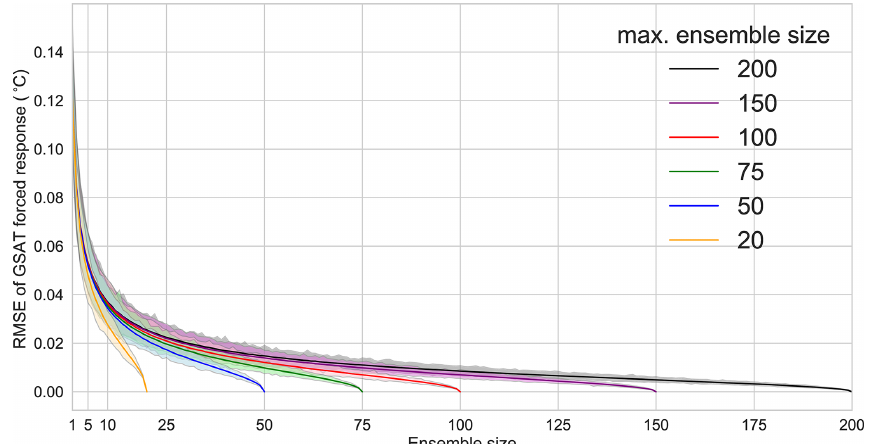
Figure A2. In a smaller ensemble, the RMSE converges to zero earlier. This is caused by resampling and does not indicate that the error is small. The black line shows the mean RMSE for GSAT for ensemble sizes from 2 to 200. The reference is the 200-member mean from Fig. 1, and the RMSE is computed for all 1000 samples. The shaded area shows the range of RMSE values for individual samples; the solid line shows the mean RMSE. The other colours show the same analysis after excluding the last 50 members (purple), 100 members (red), 125 members (green), 150 members (blue), and 180 members (yellow) from the